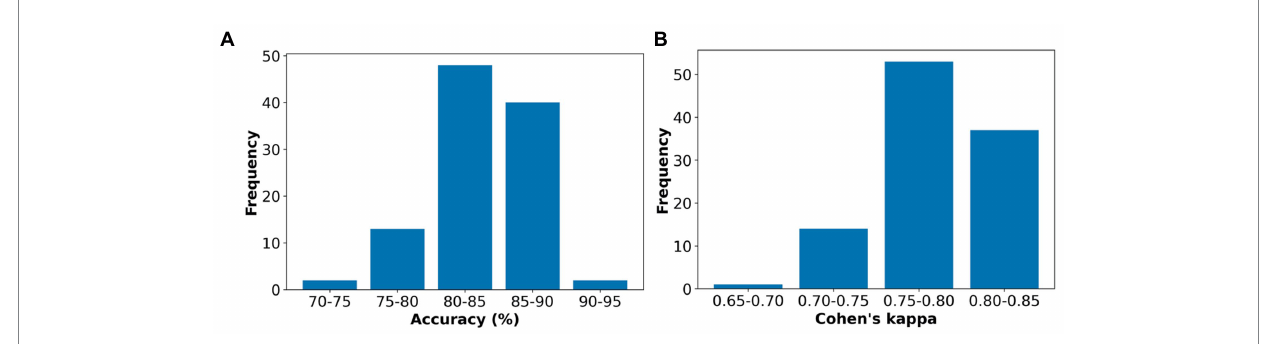
FIGURE 4 A summary of the individual-level automatic sleep stage classification performances: (A) Accuracies in percentage (range: 73.3%–90.4%) and (B) Cohen’s kappa (Range: 0.69 to 0.84) of all children comprising the aggregated test set ( n = 105) across the 10 folds during